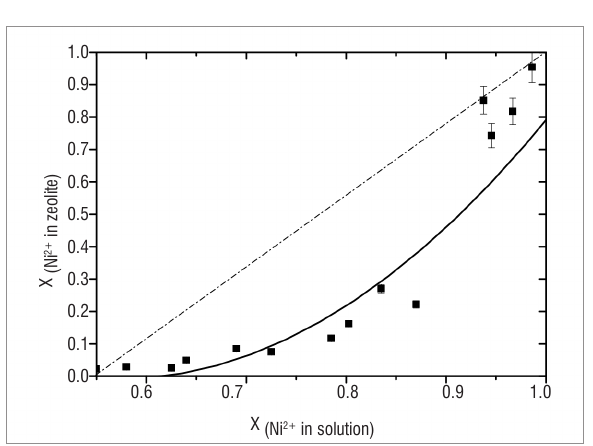
Figure 3: The natural-Ni 2+ isotherm at 298.15 K. X (Ni2+ in soln) : equivalent fraction of ingoing nickel in the liquid phase. X (Ni2+ in Zeo) : equivalent fraction of ingoing cation in the solid phase. Percentage error bars for all points are indicated. The curve was fitted to the isotherm data using a polynomial of order 2.